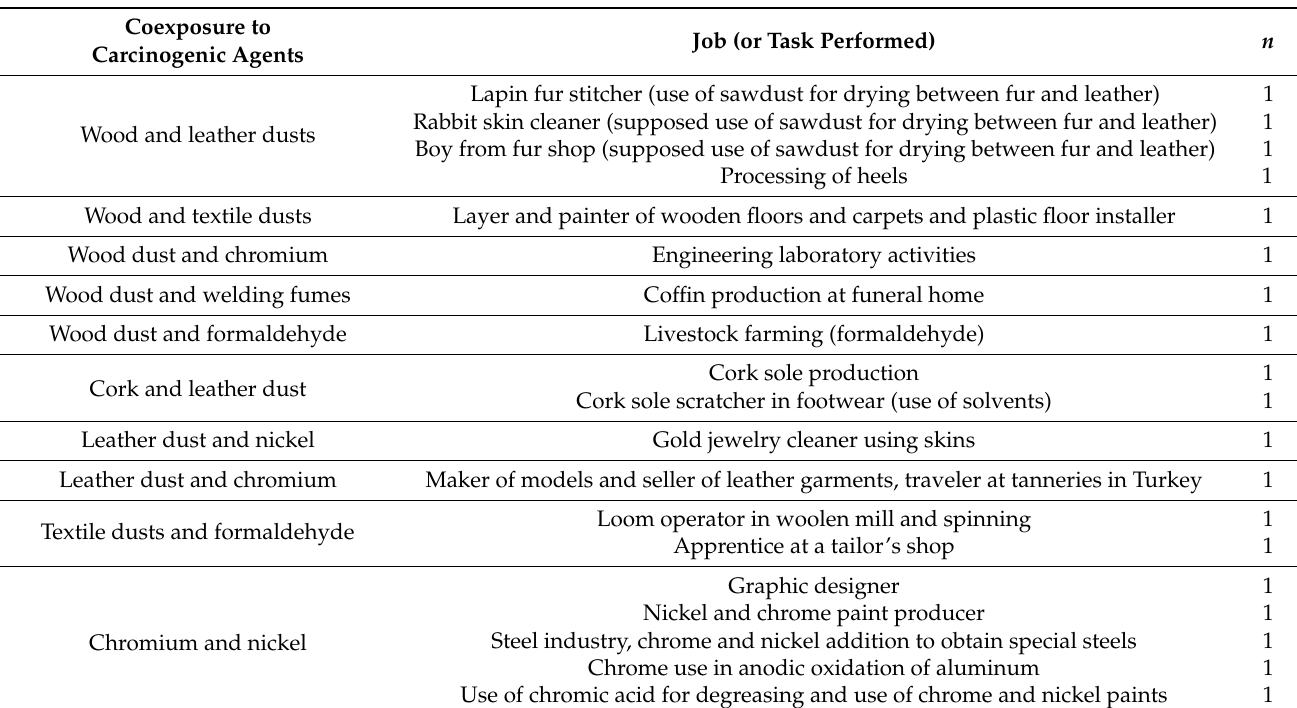
Table 3. Occurrences (n) of jobs (or tasks) with coexposures to IARC carcinogenic agents for nasal cavities and paranasal sinuses. Coexposure to Job (or Task Performed) n Carcinogenic Agents Lapin fur stitcher (use of sawdust for drying between fur and leather) 1 Rabbit skin cleaner (supposed use of sawdust for drying between fur and leather) 1 Wood and leather dusts 1 Boy from fur shop (supposed use of sawdust for drying between fur and leather) 1 Processing of heels Wood and textile dusts Layer and painter of wooden floors and carpets and plastic floor installer 1 Wood dust and chromium Engineering laboratory activities 1 Wood dust and welding fumes Coffin production at funeral home 1 Wood dust and formaldehyde Livestock farming (formaldehyde) 1 Cork sole production 1 Cork and leather dust Cork sole scratcher in footwear (use of solvents) 1 Leather dust and nickel Gold jewelry cleaner using skins 1 Leather dust and chromium Maker of models and seller of leather garments, traveler at tanneries in Turkey 1 Loom operator in woolen mill and spinning 1 Textile dusts and formaldehyde Apprentice at a tailor’s shop 1 Graphic designer Chromium and nickel